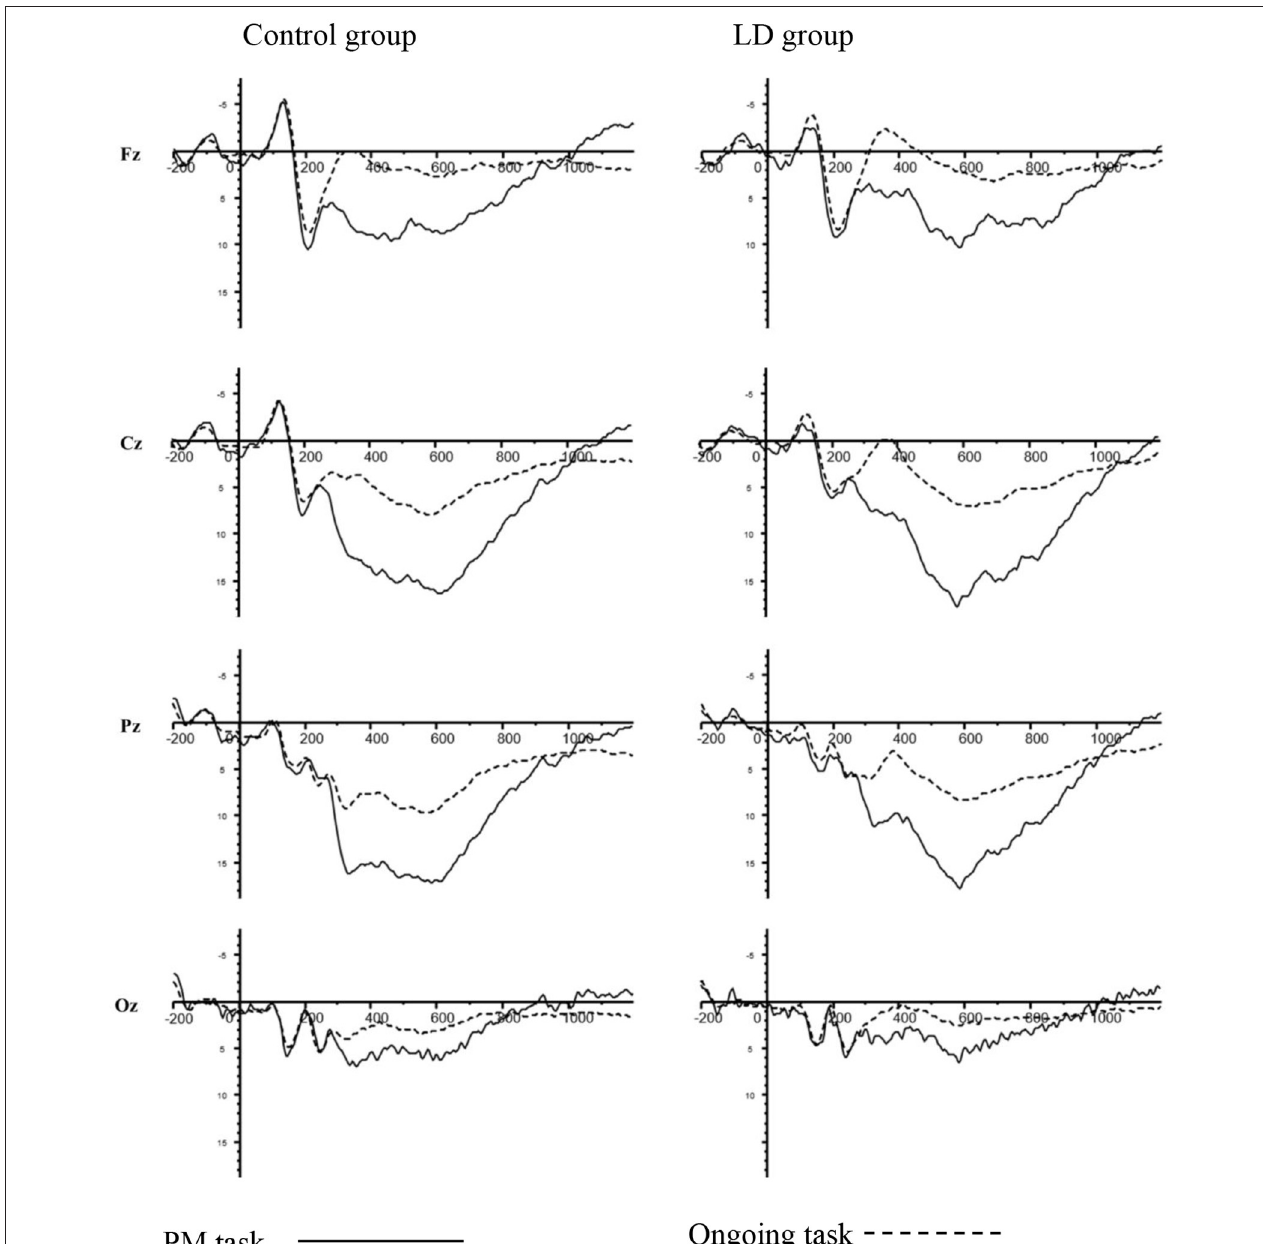
FIGURE 2 | N300 and PP for PM cue trials and ongoing activity trials in LD group and control group at Fz, Cz, Pz, and Oz electrodes.